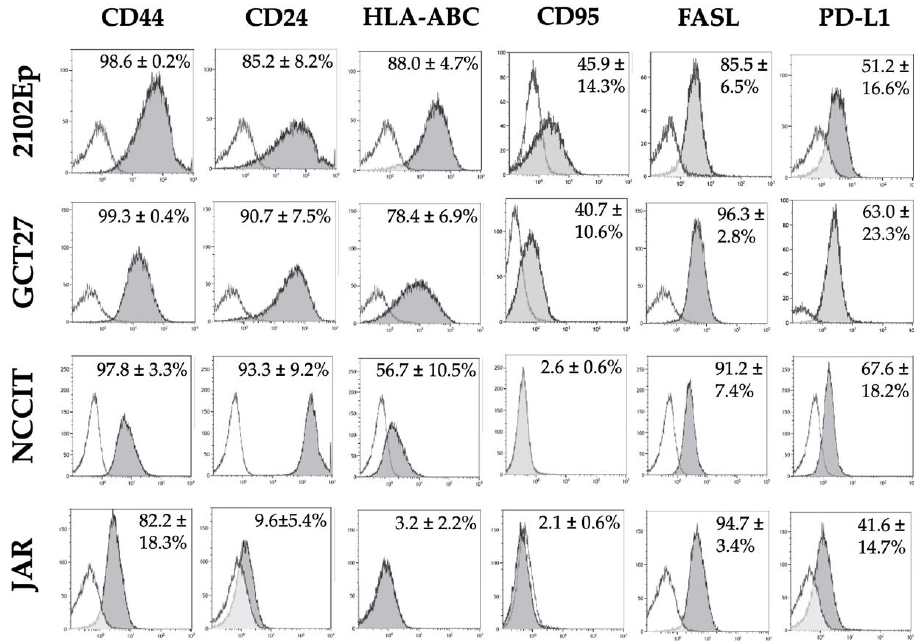
Figure 5. JAR lacks expression of antigens modulating the immune response. Expressions of di ff erent immune response-modulating proteins (grey peak of the histogram) on the tumor cell surface of four GCT cell lines were assessed by flow cytometry in comparison to the isotype control (transparent peak). The fraction of antigen-positive cells (mean ± SD) of at least three independent experiments is shown in percent in the upper right of each histogram ( n =